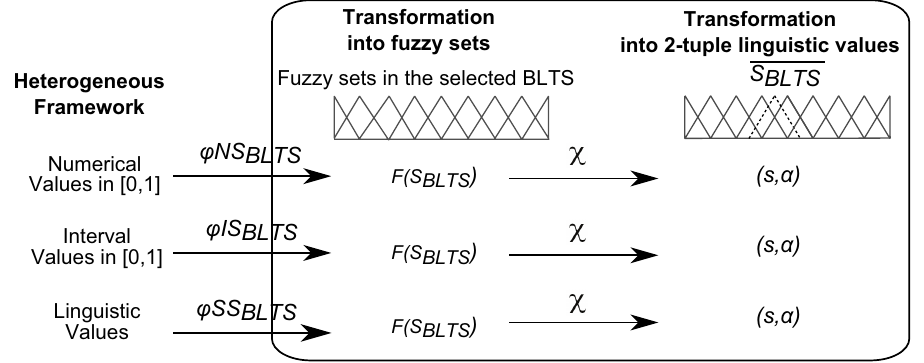
Figure 1: Fusion approach to deal with heterogeneous